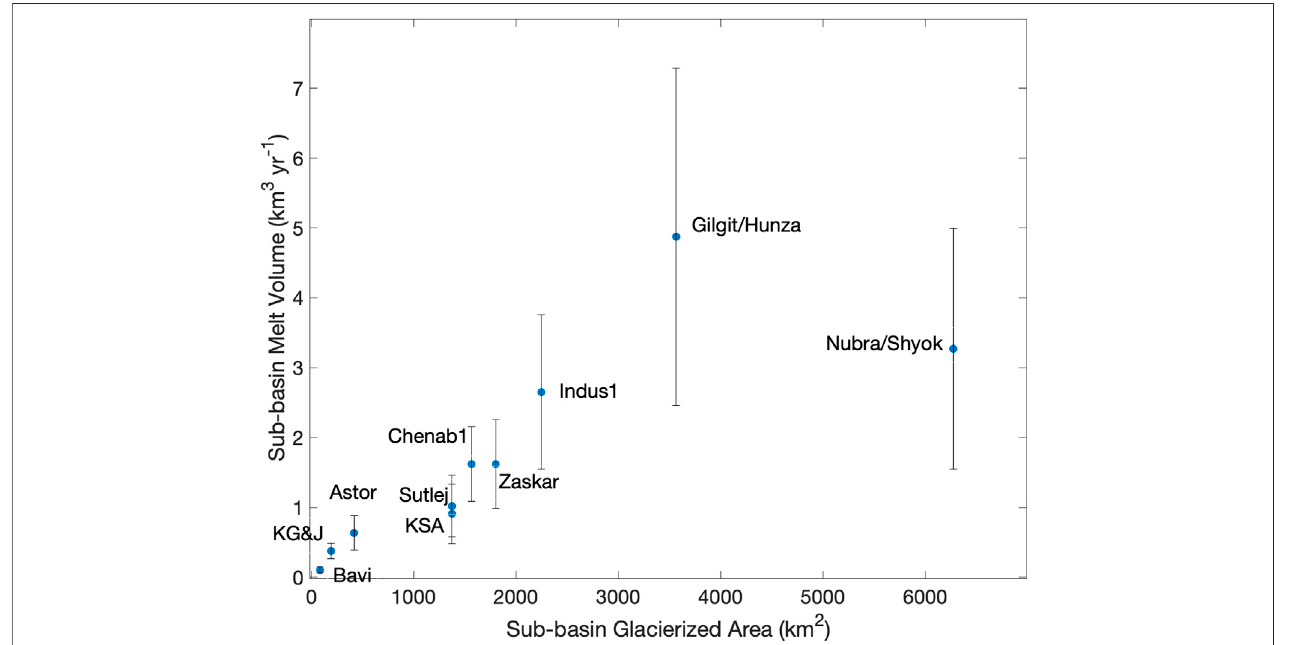
FIGURE 5 | Annual average glacier melt volume (2001 – 2013) from clean glaciers, aggregated by subbasin, for the Upper Indus Basin, with uncertainty bounds computed via a 12-glacier test set. Krishen Ganga and Jhelum are combined into a single basin (KG&J), and K/S/A is Kabul/Swat/Alingar.